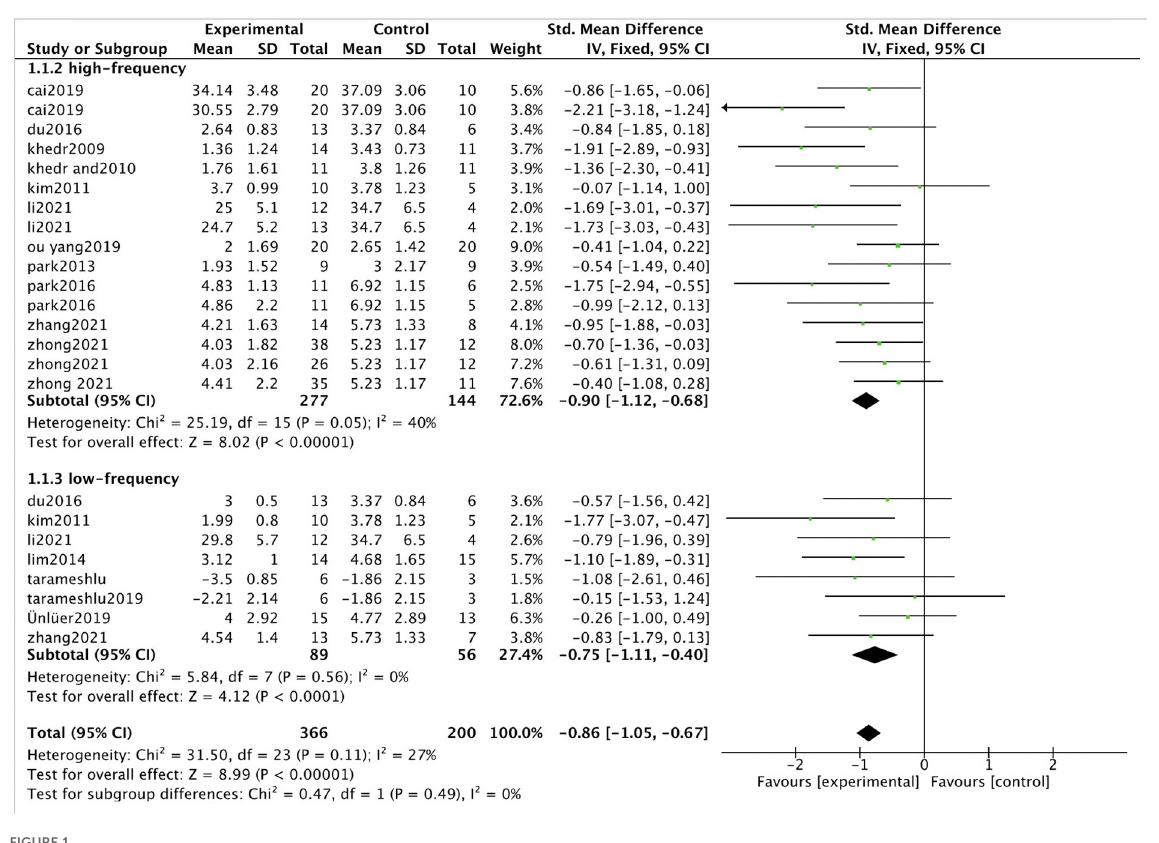
FIGURE1 Forest plot of value post-intervention to the checkpoint for swallowing function. SMD, Standardized mean difference; CI, confidence interval; N, number of